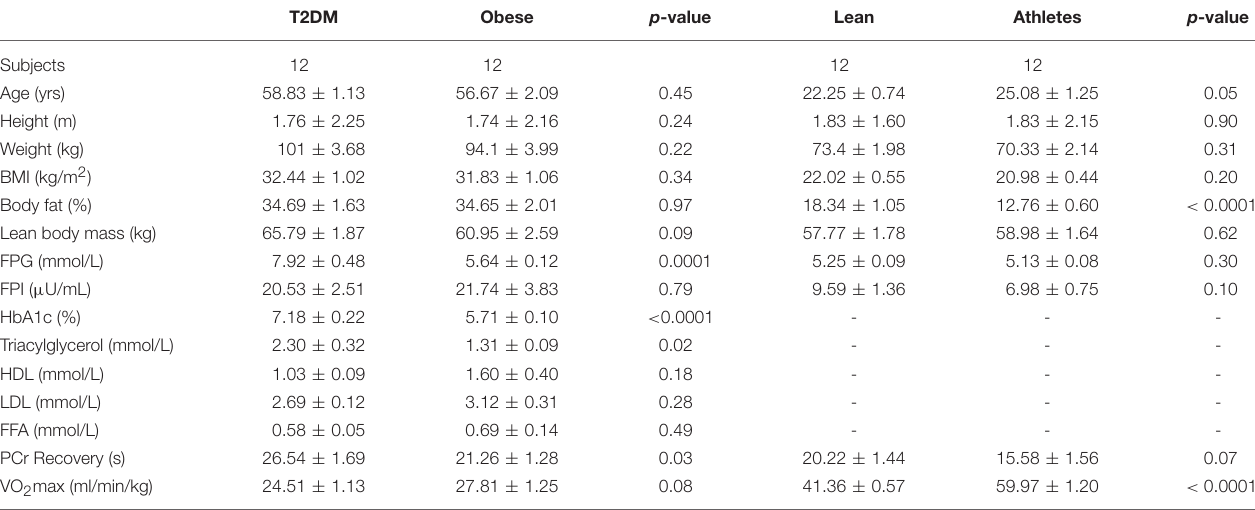
be upregulated in endurance-trained athletes compared to lean sedentary individuals ( Table 4